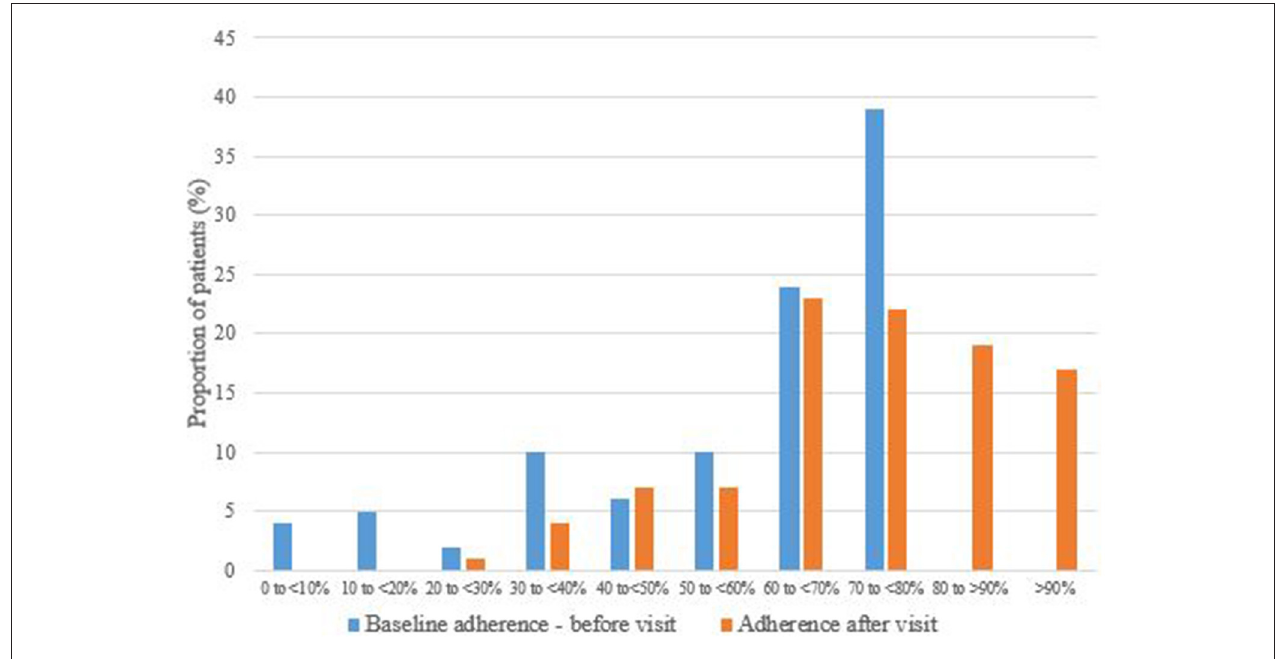
FIGURE 2 | Change in injection adherence before and after the nurse